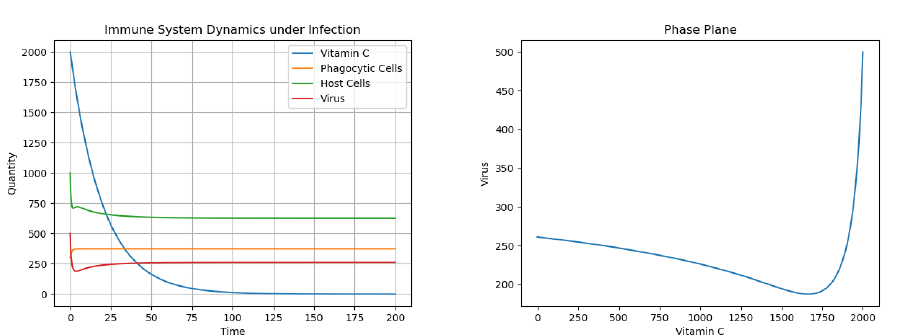
Figure 11. Dynamics under CGD with Moderate Constant Infusion of Vitamin C